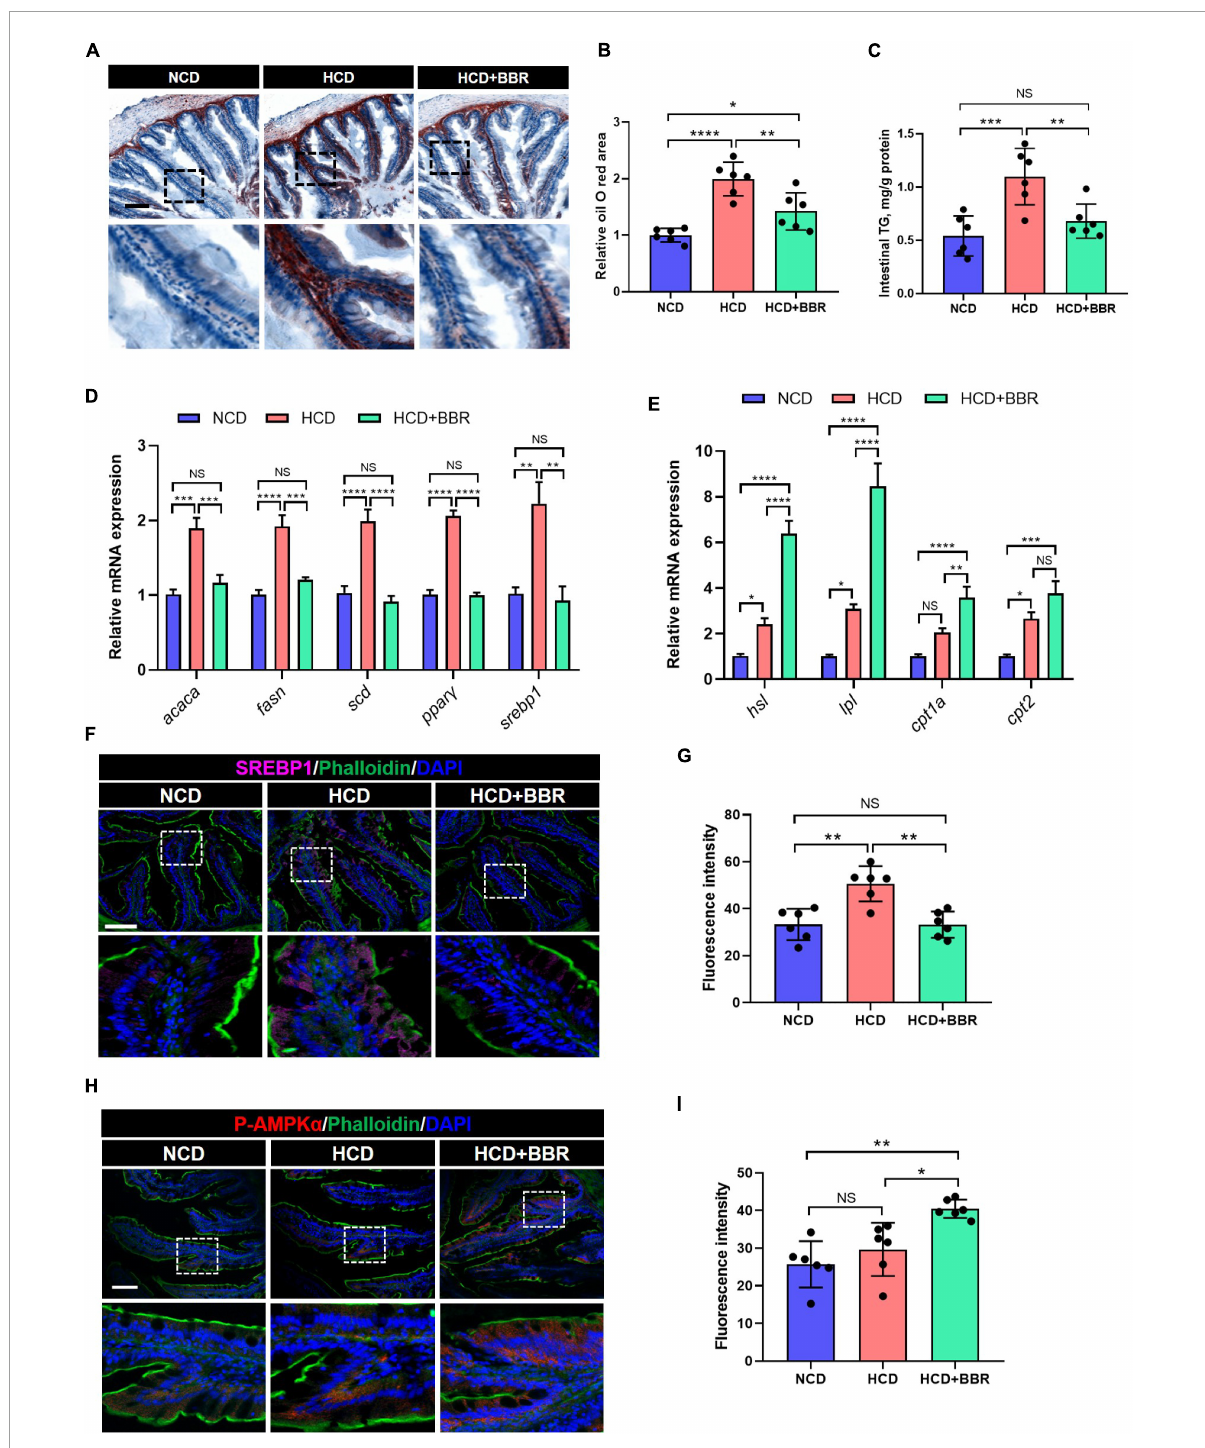
FIGURE5 Dietary BBR reduced the HCD-induced excessive lipogenesis and promoted lipid catabolism via activating AMPK and inhibiting SREBP1 in the intestine of largemouth bass. (A) Oil Red O staining images of intestinal sections (bar = 100 µ m). (B) Relative oil Red O area in intestinal sections. (C) Intestinal TG level. (D) Expression level of lipogenesis genes. (E) Expression level of lipolysis and fatty acid oxidation genes. (F) SREBP1 (pink) staining images of intestinal sections (bar = 100 µ m). (G) Quantification of the SREBP1 fluorescence intensity. (H) P-AMPK α (red) staining images of intestinal sections (bar = 100 µ m). (I) Quantification of the P-AMPK α fluorescence intensity. Data are represented as means ± SEM ( n = 6). *, **, ***, ****Different from each other: * P < 0.05, ** P < 0.01, *** P < 0.001, **** P < 0.0001, NS means no significant difference (One-way ANOVA, Duncan’s post hoc